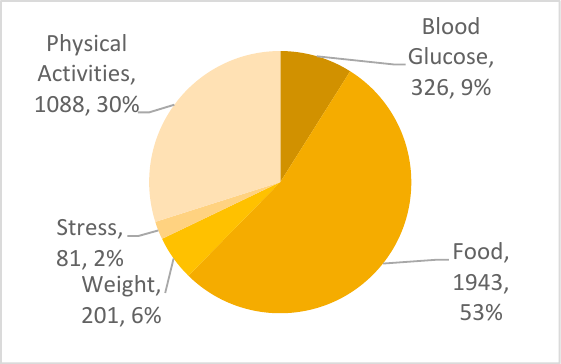
Figure 5. The frequency of tasks recorded in i-PreventDiabetes.